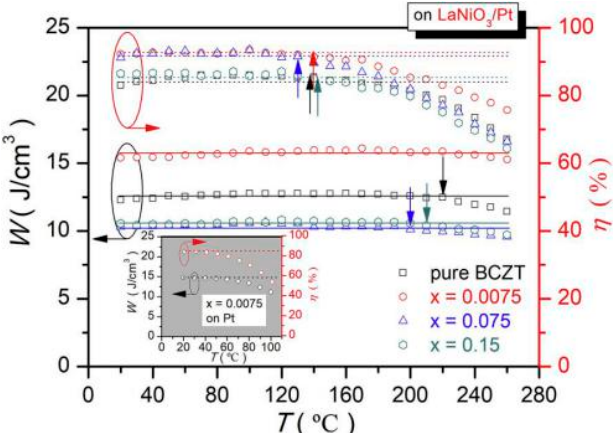
Figure 22. W (T) and η (T) of pure and La-doped BCZT thin films on LaNiO 3 /Pt Composite bottom electrodes. Reprinted with permission from [93]. Copyright 2019 Elsevier Ltd. and Techna Group S.r.l.